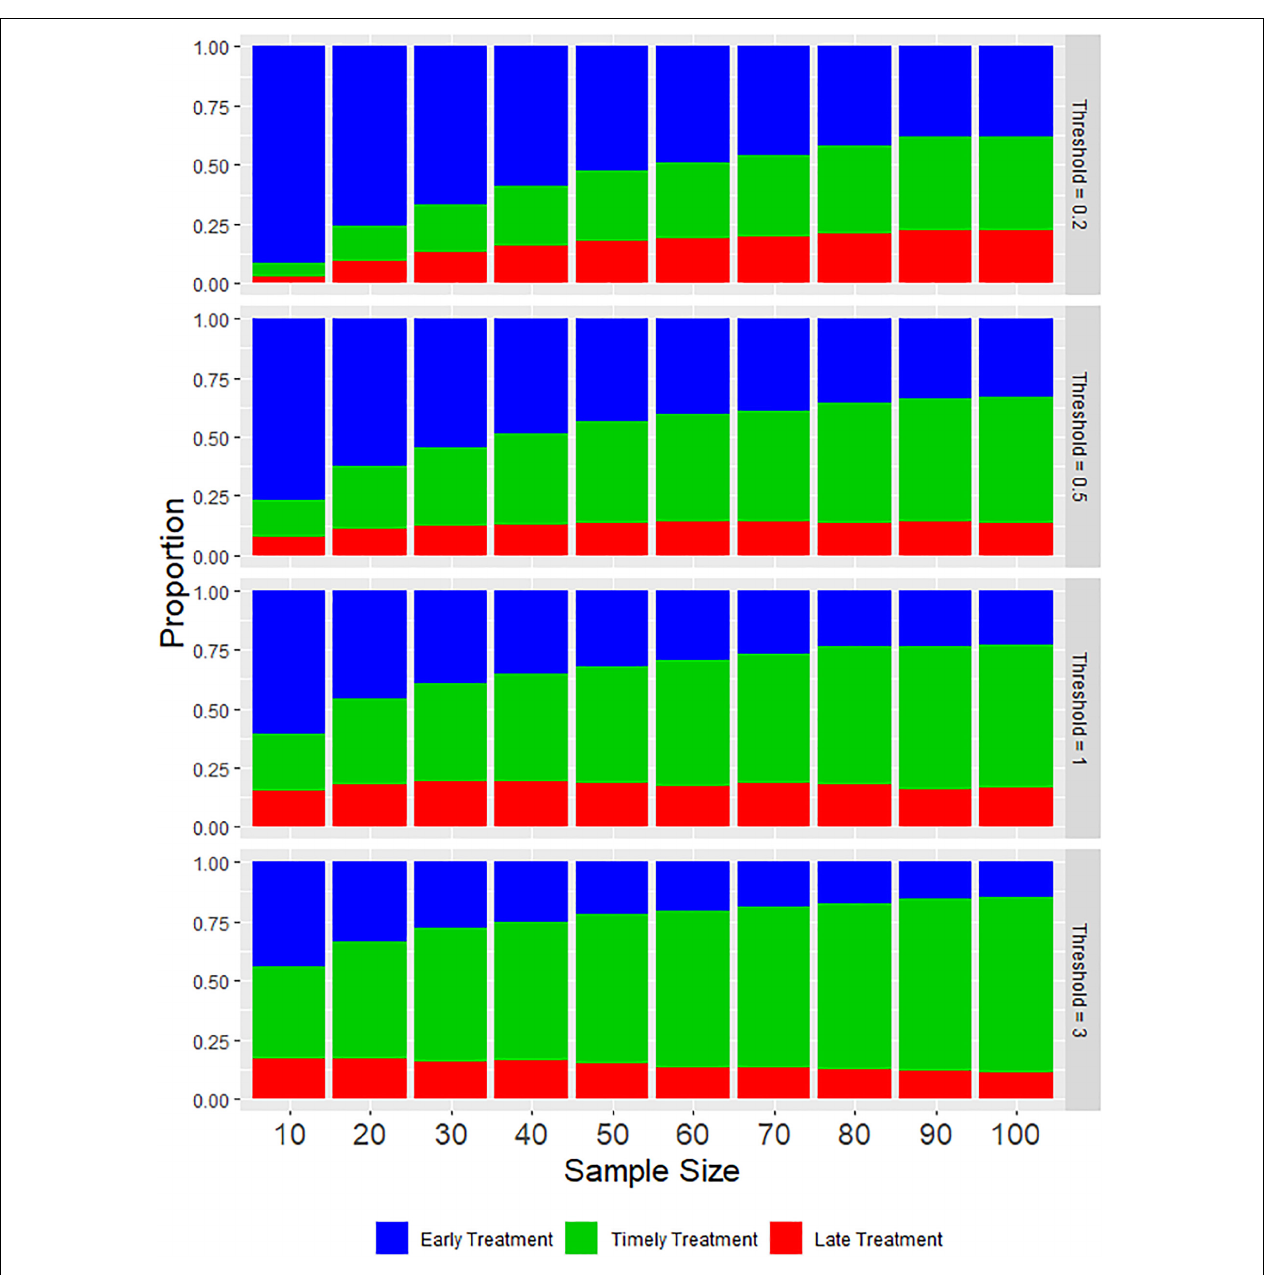
FIGURE 2 | Stacked bar charts illustrating the average proportions of each type of treatment during a production cycle based on various values of sample size and treatment